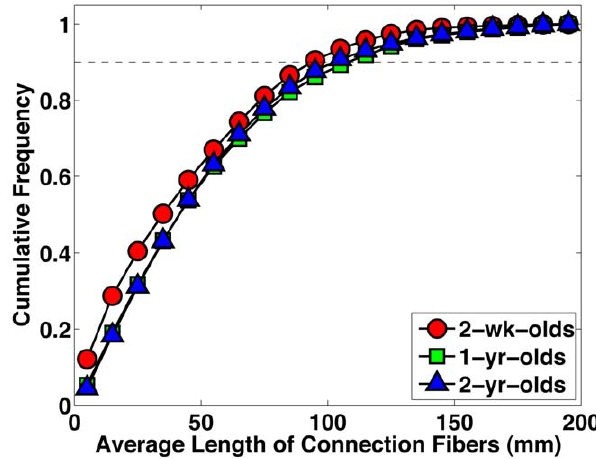
Figure 5. Inter-Region Connection Fiber Length Distribution. Cumulative distribution plots of the inter-region connection fiber lengths indicate that there is a progressive maturation of long fibers with growth. The dashed horizontal line marks the 0.90 frequency point and indicates that only a small fraction of the fibers are long fibers.